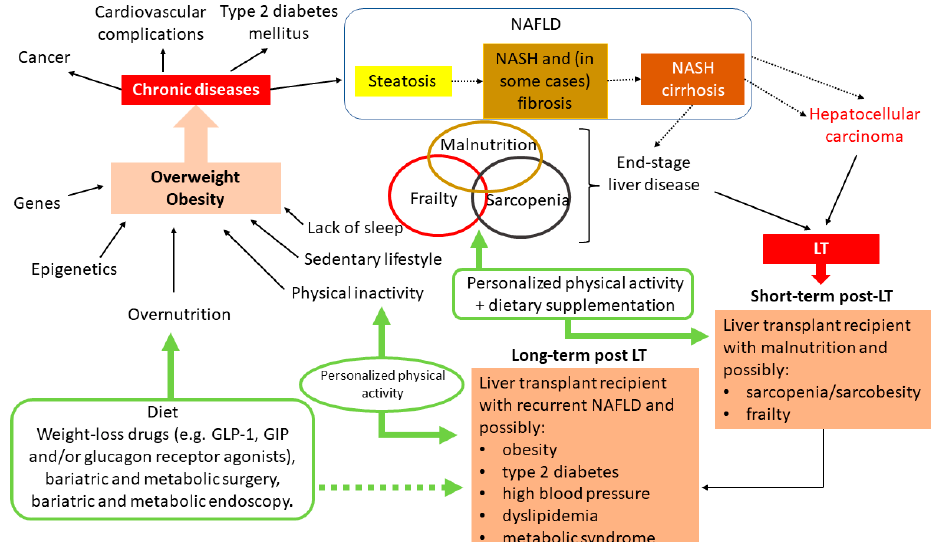
Figure 1. Summary of the possible treatment effects of PA in overweight or obese individuals (particularly those with NASH cirrhosis). NAFLD : non-alcoholic fatty liver disease; NASH : nonalcoholic steatohepatitis; GIP : glucose-dependent insulinotropic polypeptide; GLP-1 : glucagon-like peptide-1.